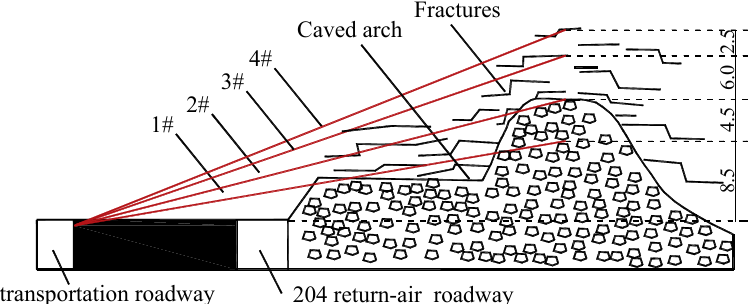
Figure 7. The schematic map of the mine and research area (the area circled in brown lines is the test drilling area).